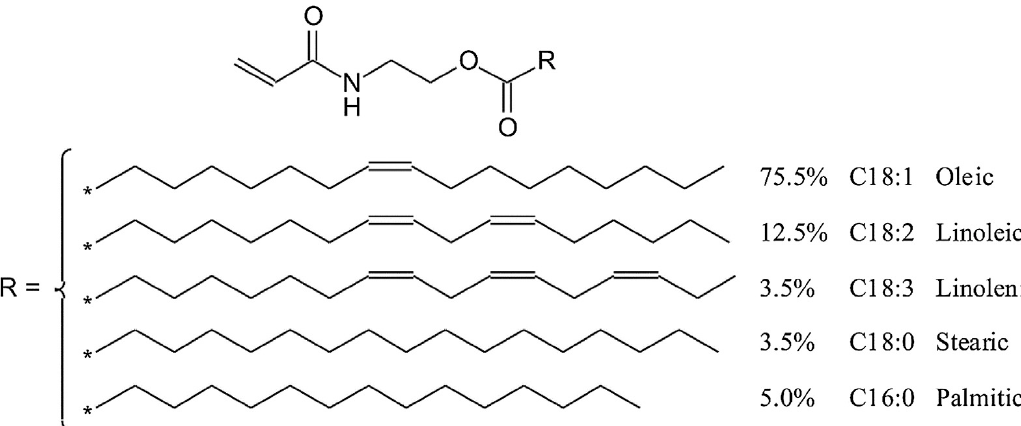
Figure 9. General formula of the plant oil-based monomers. Reprinted from [32]. Copyright (2018), with permission from Elsevier.